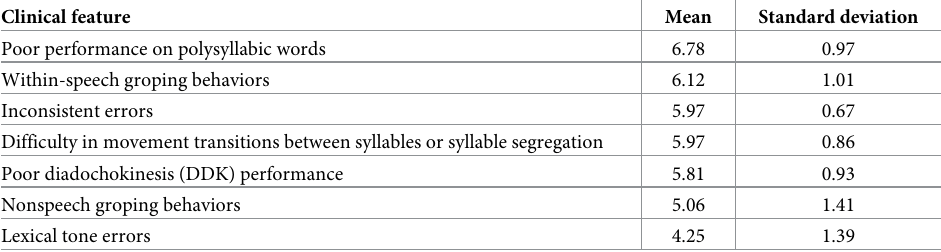
Table 3. Descriptive statistics of ratings of seven clinical features of childhood apraxia of speech for making a dif- ferential diagnosis.